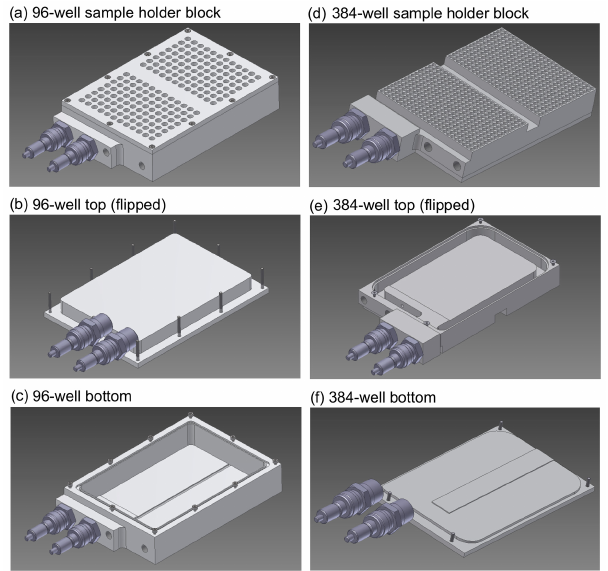
Figure 1. Sample holder and cooling blocks of the Twin-plate Ice Nucleation Assay (TINA) with (a–c) 96-well plates and (d–f) 384- well plates (CAD